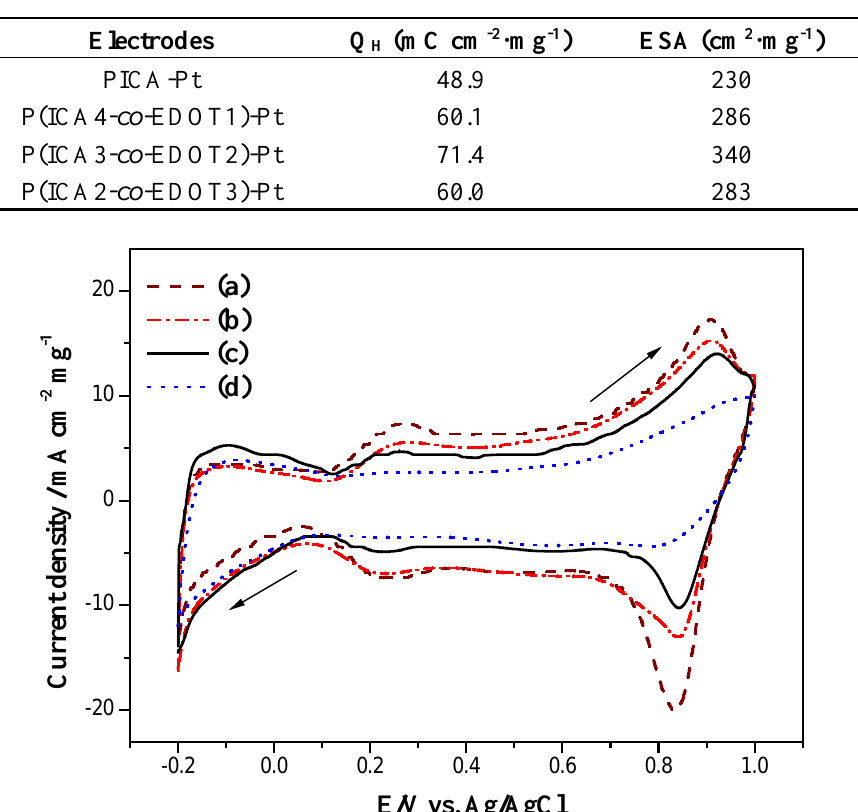
Table 1. The ESA values of Pt supported on the electrodes.